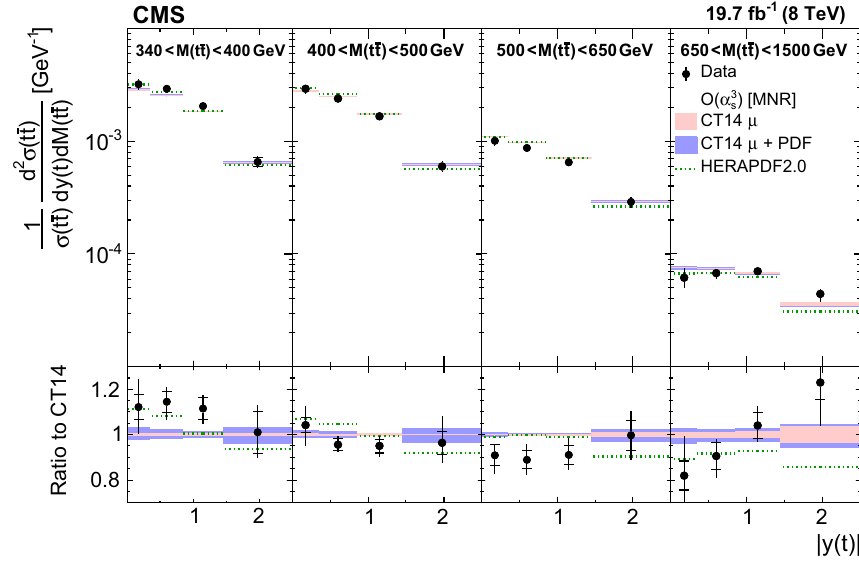
for the NLO predictions using CT14, while the dark band includes also the PDF uncertainties added in quadrature ( μ + PDF). The dotted line shows the NLO predictions calculated with HERAPDF2.0. The dashed line shows the approximate NNLO predictions calculated with CT14. In the bottom panel , the ratios of the data and other calculations to the NLO prediction using CT14 are shown